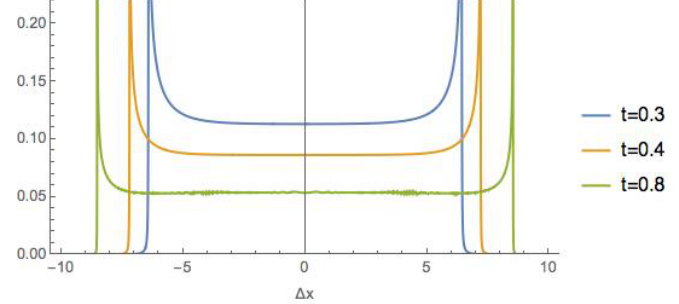
Figure 11 . x 2 6 = x 1 , t 2 = | t 1 | with a delta function source centered around different values of t .